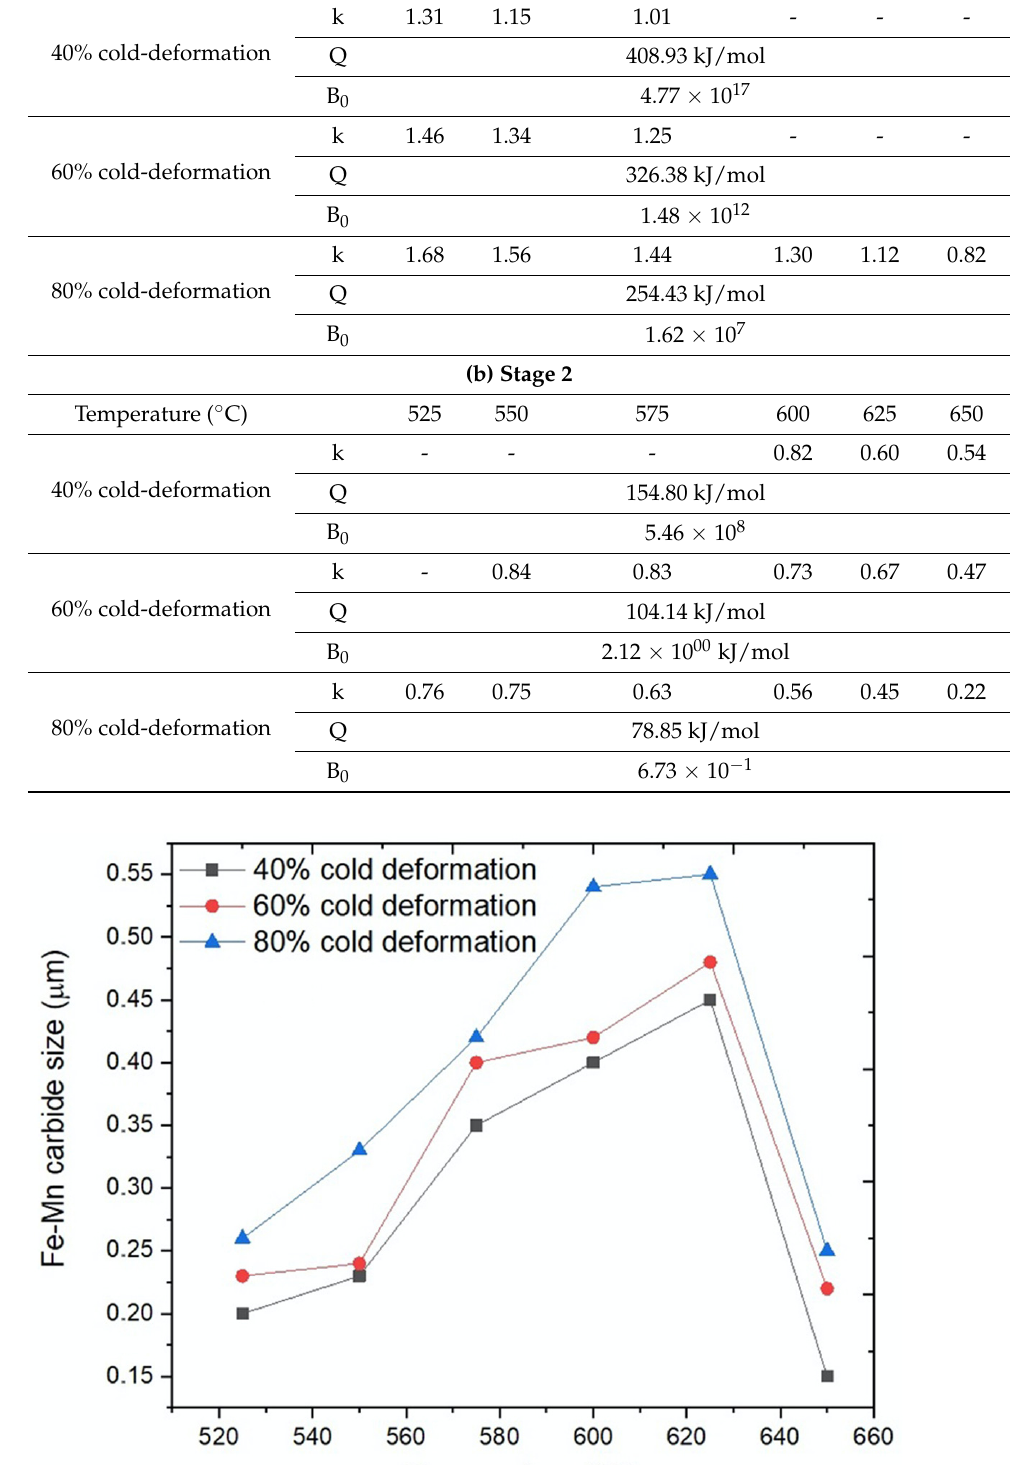
Figure 11. Evolution of (Fe,Mn) 3 C size with annealing temperature for different cold-deformation levels.